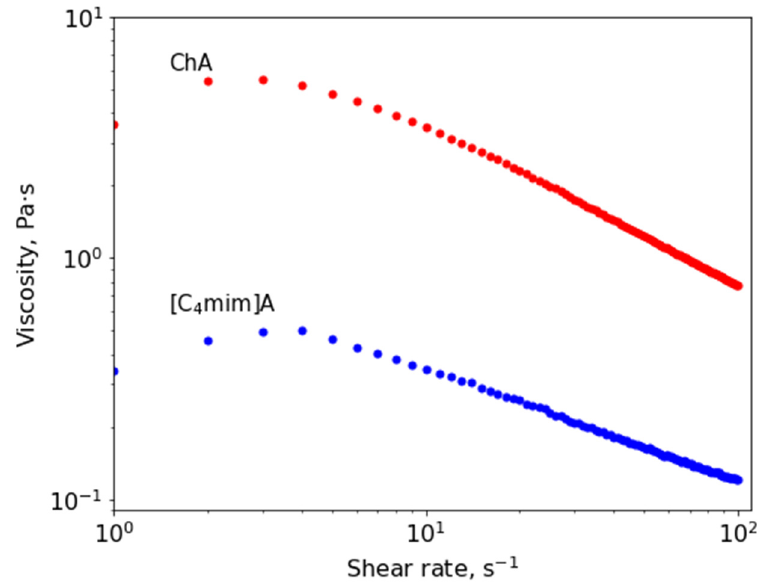
Figure 4. Dependence of the viscosity of pure mILs on the shear rate at T = 298